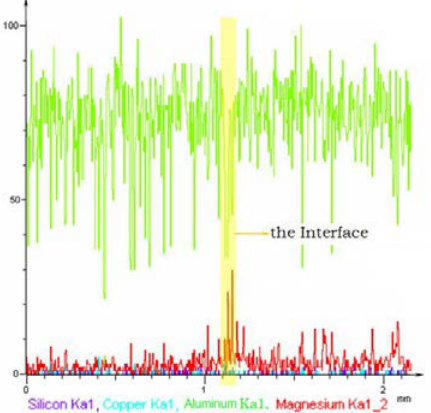
Figure 11. Element distribution at the grain boundary: ( a ) natural cracking surface, ( b ) elemental distribution.